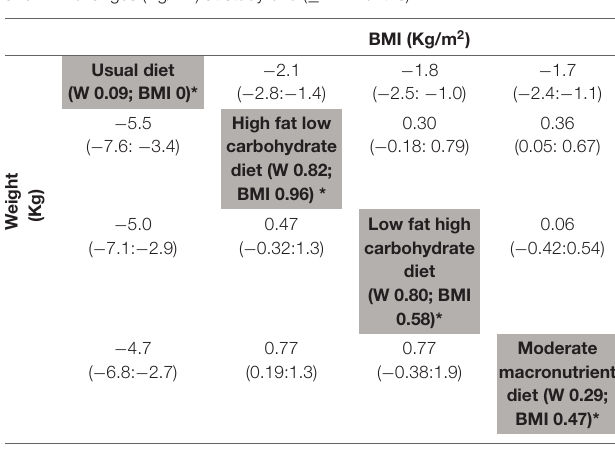
TABLE 3 | League table of network meta-analysis results of waist circumference changes (cm) at study end ( ≥ 12